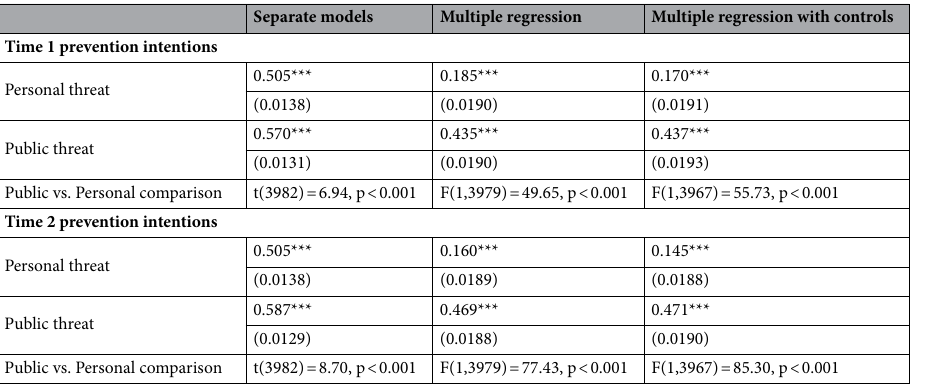
Table 6. Associations between threat variables and prevention intentions in Study 3. We report results from regressions predicting prevention intentions as a function of our threat variables, across Studies 3a–d. Shown are results from (i) a set of separate regression models for each threat variable (Column 1) and (ii) multiple regression models using both threat variables (Columns 2–3), when predicting prevention intentions at Time 1 (top rows) and Time 2 (bottom rows). We show results from multiple regression models both with and without controls for age, gender, education, race, income, and political party affiliation. All coefficients are standardized coefficients, with standard errors for each coefficient in parentheses. For each model, we also report results from a test comparing the public versus personal threat coefficient. Standard errors in parentheses. ***p < 0.001, **p < 0.01, *p <